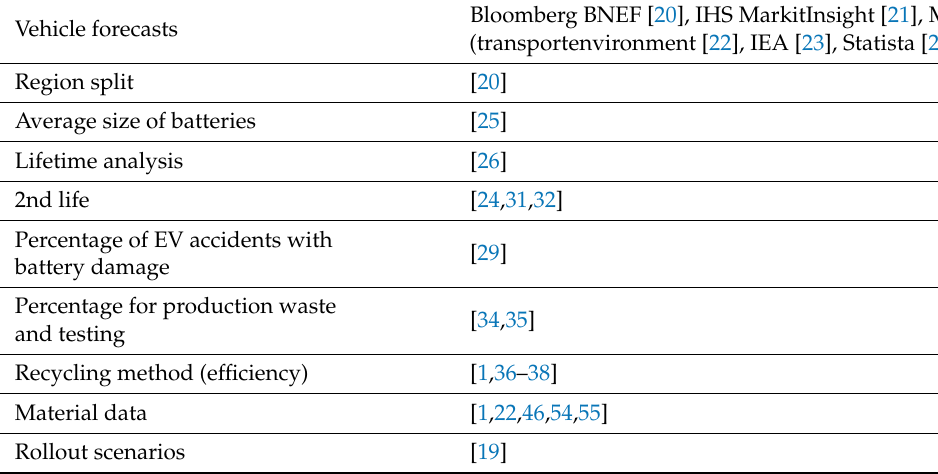
Table A1. Summary of sources per section used in the